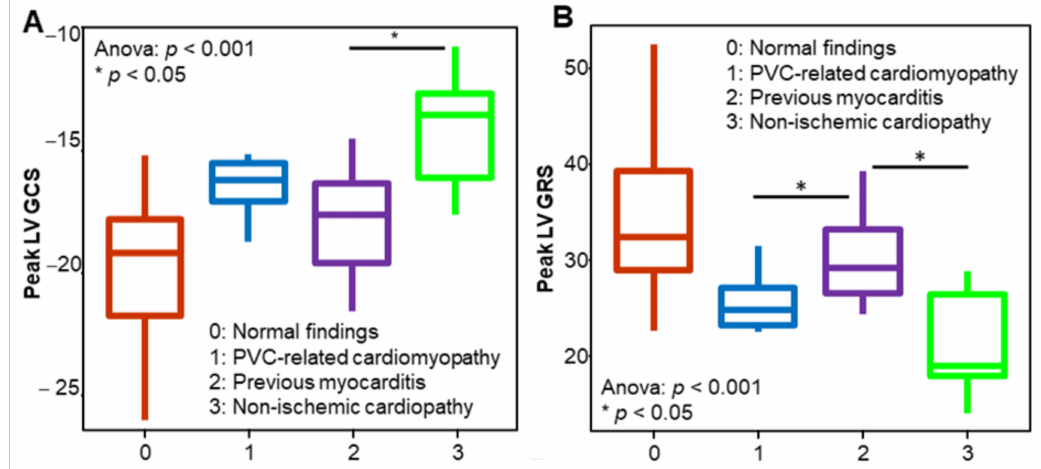
Figure 4. Box plots showing the median values of the peak left ventricular global circumferential strain (LV GCS) ( A ) and the peak left ventricular global radial strain (LV GRS) ( B ) in the different patient groups. Patients with non-ischaemic cardiomyopathy had a significantly impaired peak LV GCS and peak LV GRS compared with patients with previous myocarditis. The peak LV GRS can also differentiate between patients with previous myocarditis and those with premature ventricular contraction (PVC)-related cardiomyopathy. The asterisk indicates p <